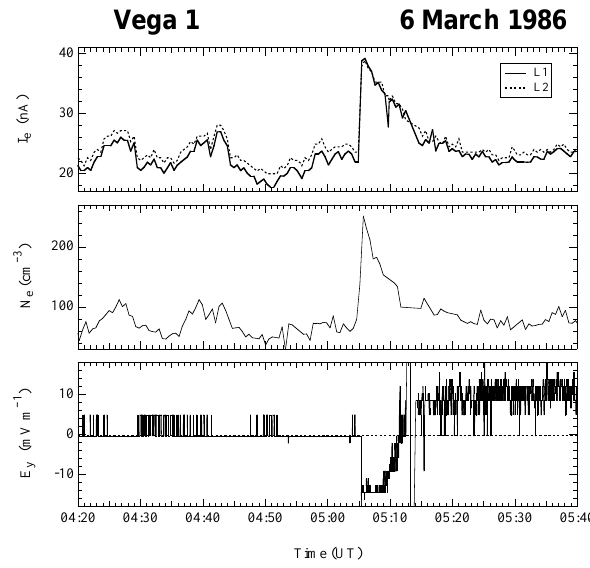
Fig. 10. Plasma and field measurements for Vega 1 at 04:20–05:40 UT. The panels, from top to bottom, are the electron fluxes at L1 and L2, electron density derived from L1 data, and dc electric